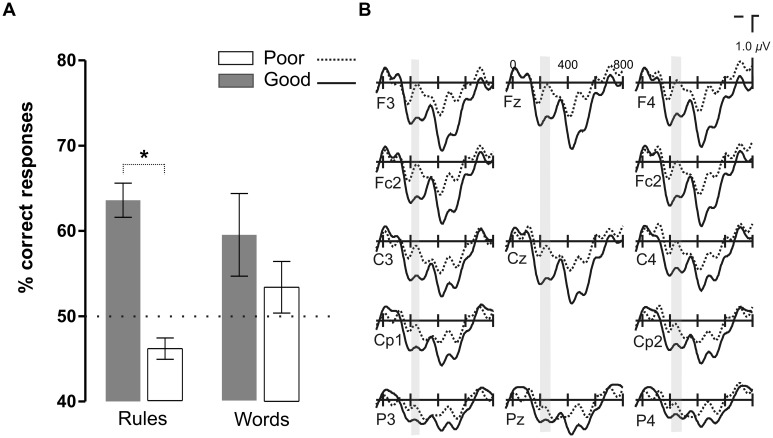
Results of the comparison between the two groups of participants split as a function of their rule learning performance in Continuous Language condition. (A) Word and rule-learning performance in the two groups of participants. The groups differed in terms of their rule learning performance but were matched in their word learning performance. (B) Grand average ERP waveforms corresponding to good (Good) and bad (Poor) rule learners in the Continuous Language condition.